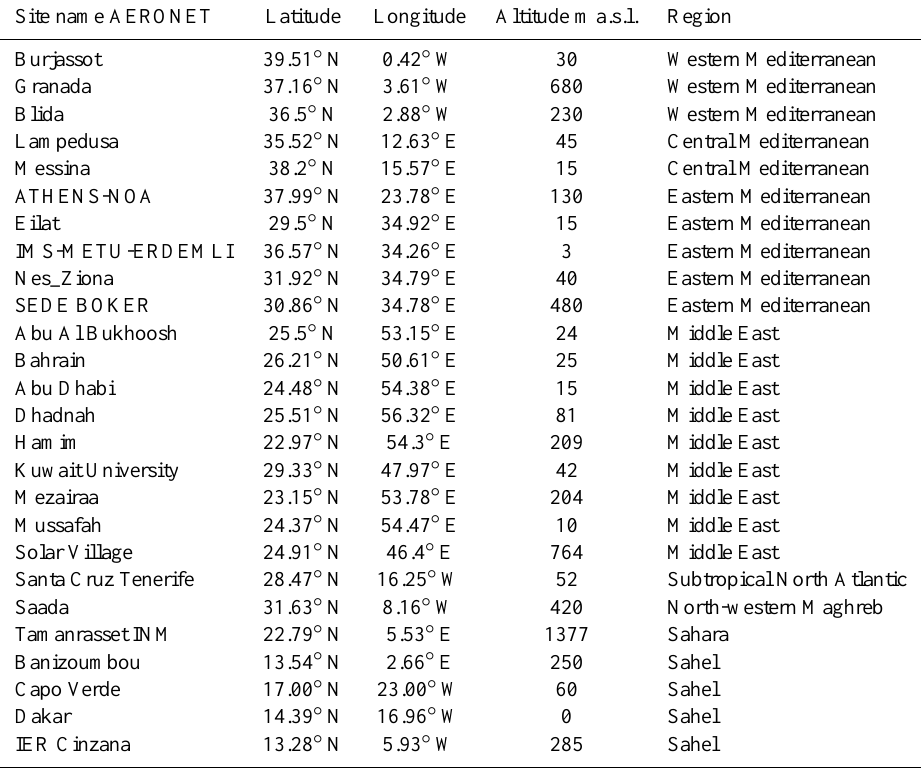
Table 1. Name and location of the AERONET stations. Cloud screened and calibration quality-assured AERONET level 2.0 data has been extracted for each